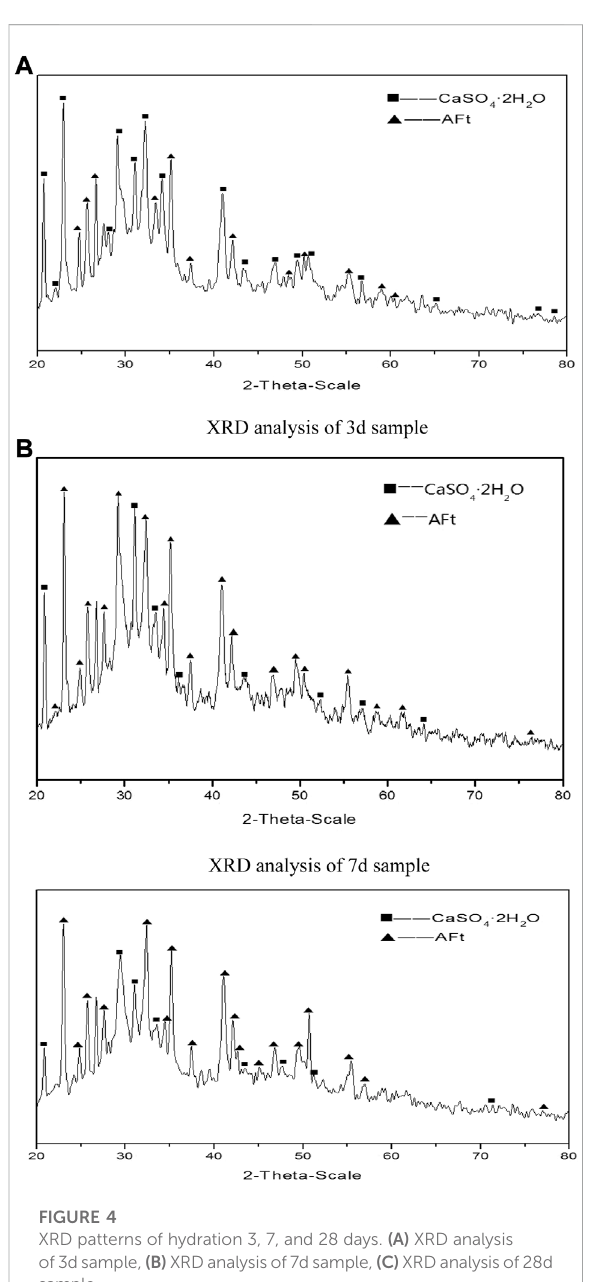
FIGURE 4 XRD patterns of hydration 3, 7, and 28 days. (A) XRD analysis of3dsample, (B) XRDanalysisof7dsample, (C) XRDanalysisof28d